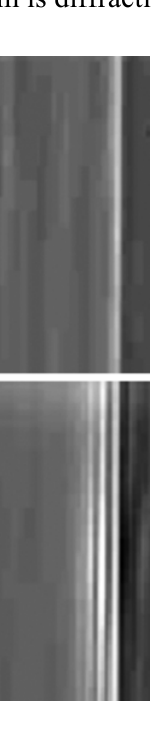
Figure 15. Images of the same edge of an optics fiber taken with different experimental geometries [23, 24]. In the top image, the edge enhancement is due to refraction effects whereas in the bottom case the mechanism is